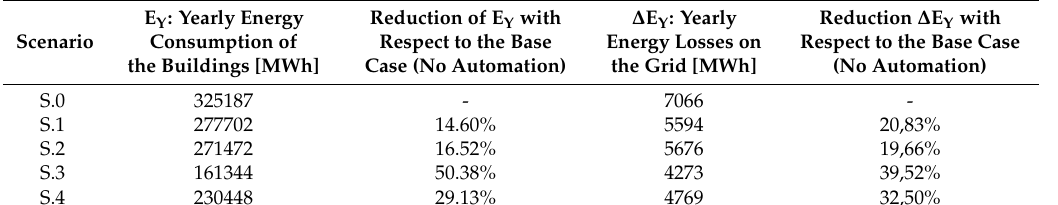
Table 5. Turin—Energy consumptions and losses for the different control logics (Presence of FV).